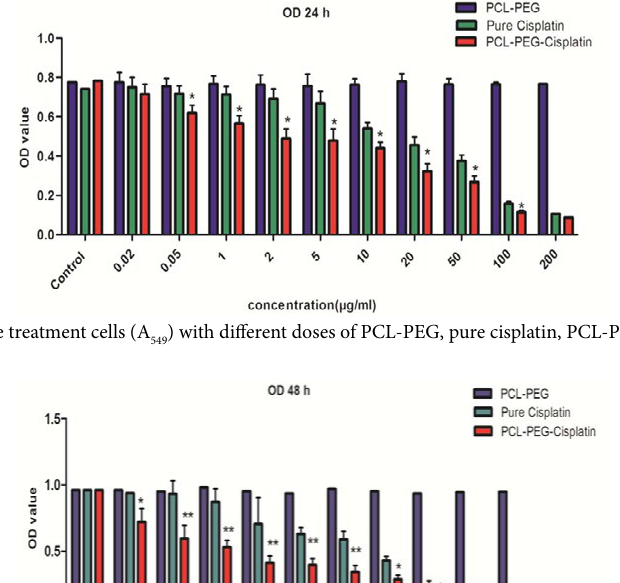
) with different doses of PCL-PEG, pure cisplatin, PCL-PEG- cisplatin in 48 549